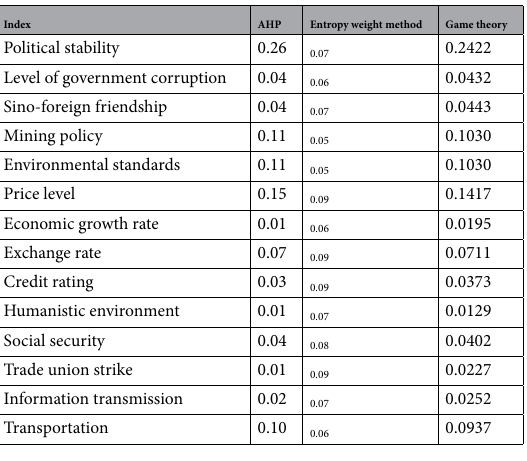
Table 4. Calculated index weights.